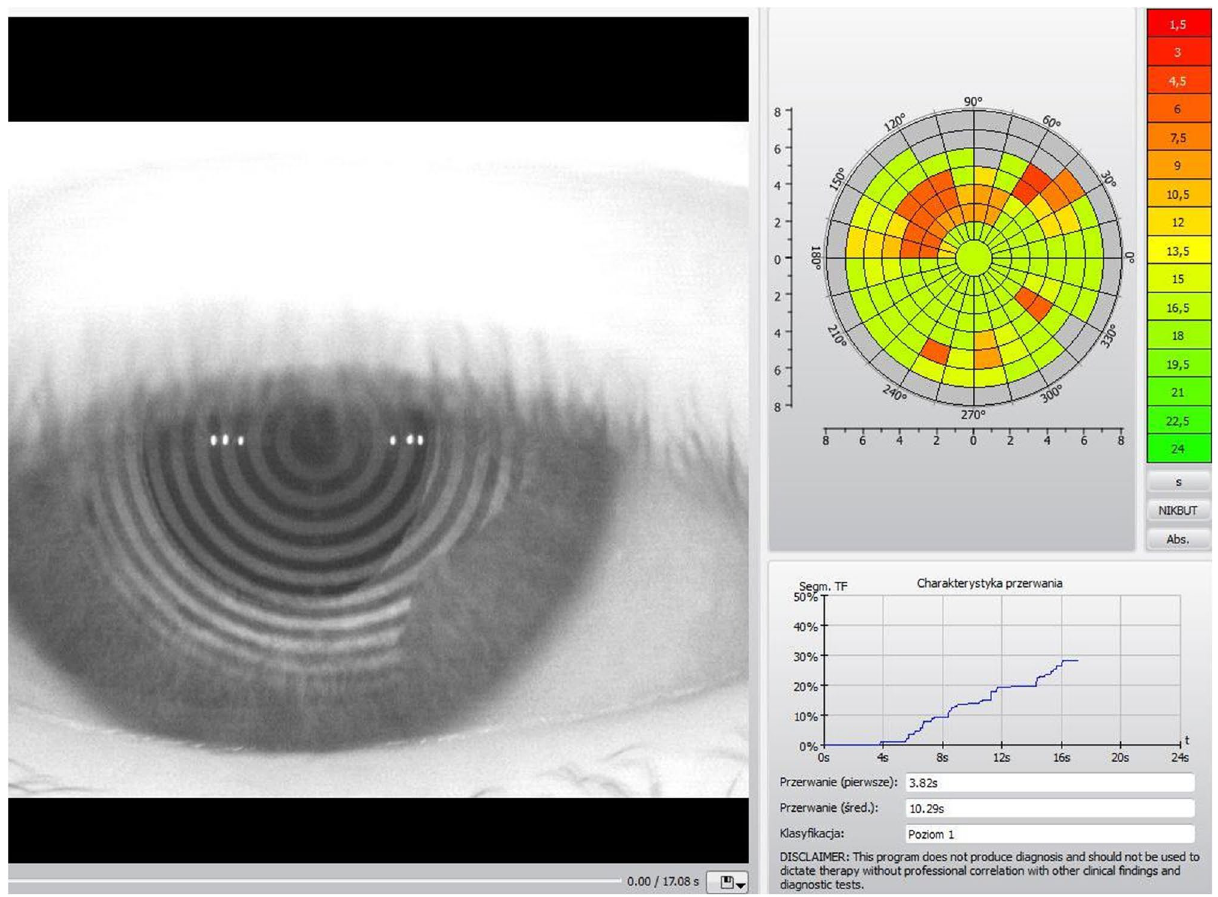
Figure 4. The TearMap by Keratograph 5 M: the respective break up time is graphically illustrated for each segment in seconds—unstable tear film (red and orange segments are related to unstable tear film). Photo: Witold Tarkowski. NIBUT (seconds) First break up time, right eye Group n